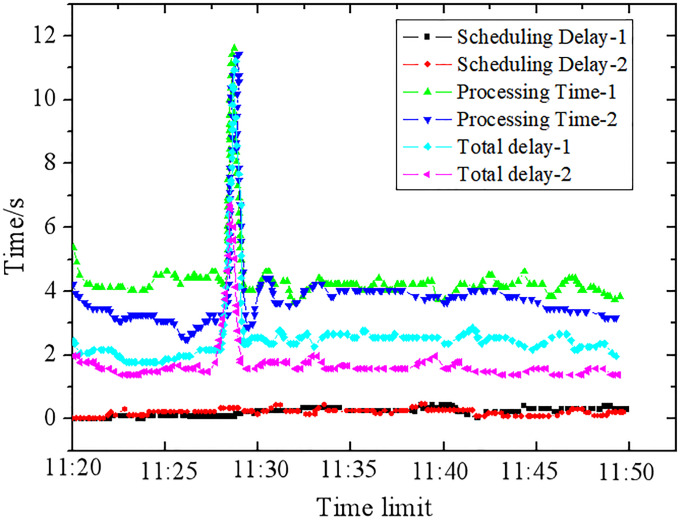
Handling of latency and processing time by Spark for 2000 elevators.